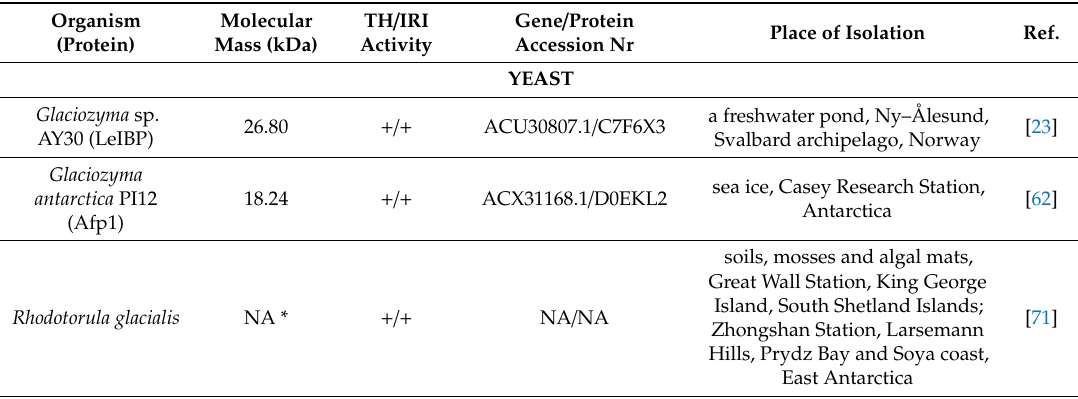
Table 1. Examples of psychrophilic organisms and antifreeze proteins (AFPs) produced by